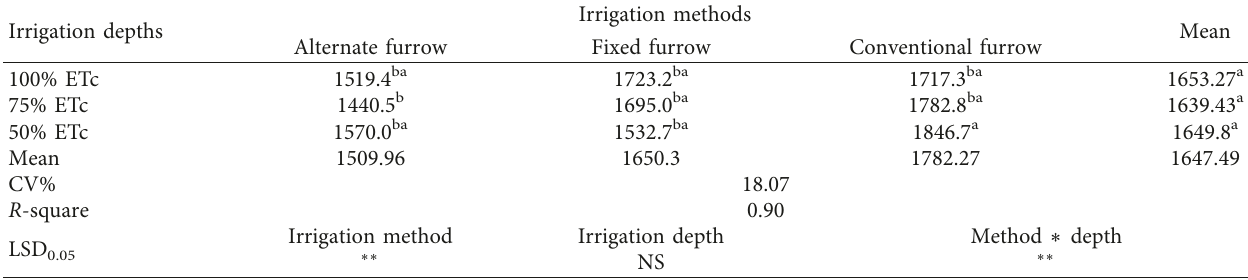
Table 3: Sesame response to deficit irrigation and combined mean yield (kg/ha) over years (from 2013 to 2015) during the main cropping season.